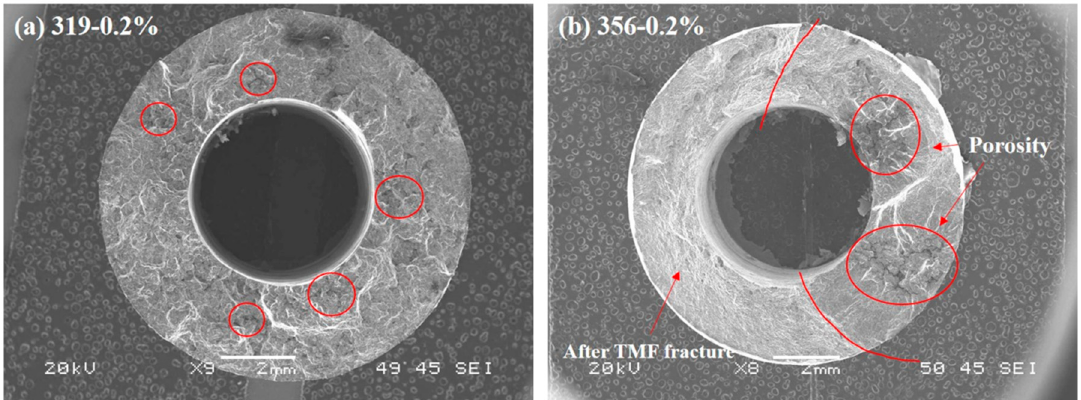
Figure 5. Fracture surface after 0.2% TMF test: ( a ) 319 alloy; ( b ) 356 alloy.